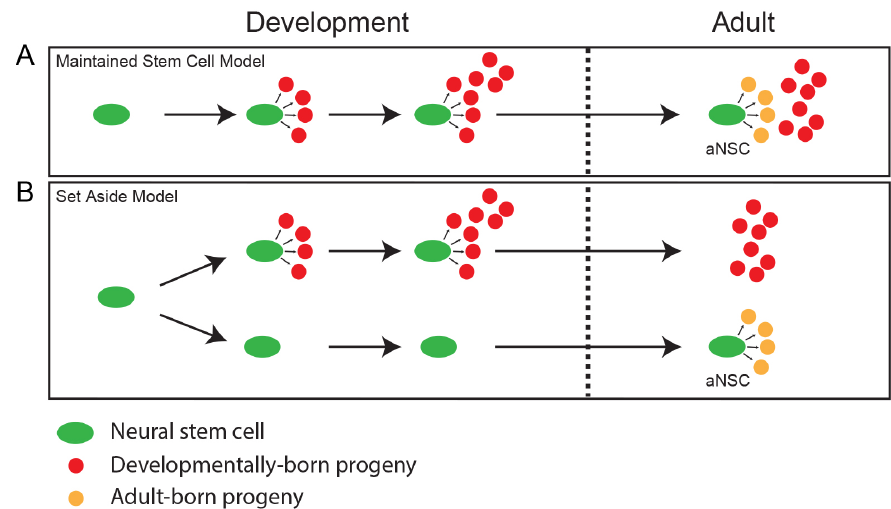
Figure 4. Developmental origin of adult neural stem cells (NSCs). There are two models that explain how adult NSCs are generated during development. It should be noted that these models are not mutually exclusive but can coexist. ( A ) Maintained stem cell model: NSCs that produce mature cell types to populate the dentate gyrus (DG) during development remain in the adult DG and transition into more quiescent activated NSCs (aNSCs) which generate neurons in the adult DG. ( B ) Set aside stem cell model: a subset of NSCs are set aside in a quiescent state during development and do not participate in populating the DG with mature cell types. Once the DG is formed, these NSCs are the aNSCs and can reactivate to generate neurons in the adult